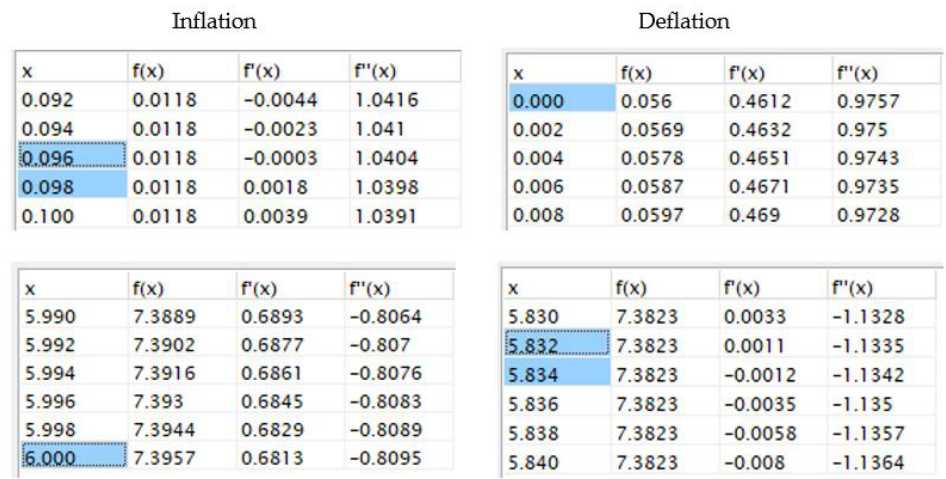
Figure 9. Evaluation of the slope of the tangent to the curves defined by Equations (5) and (6).